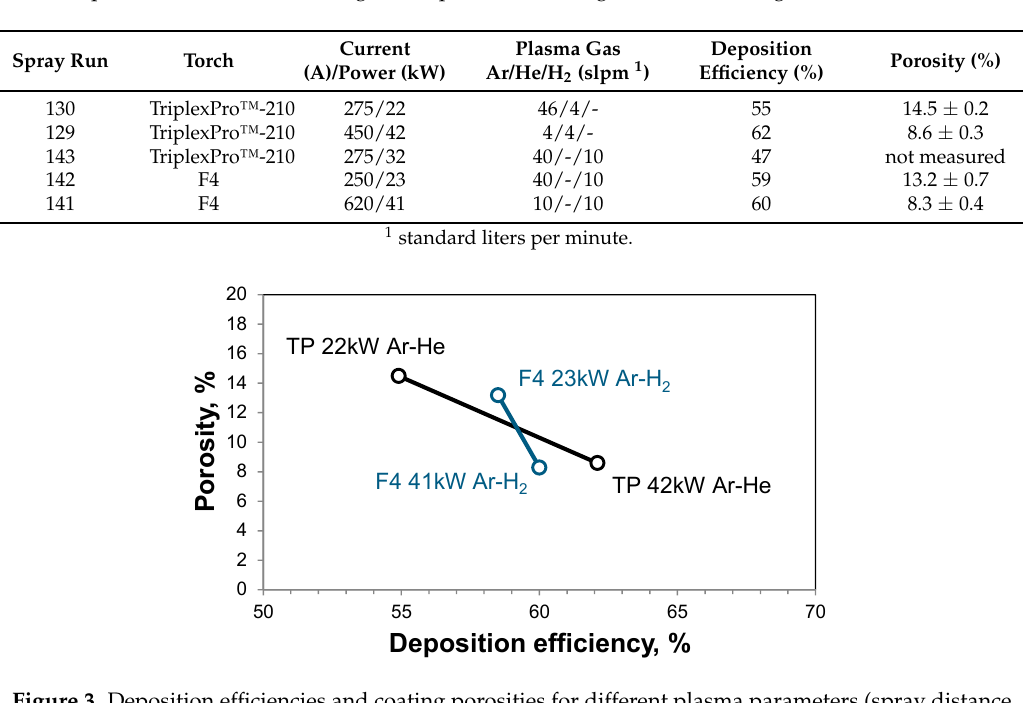
Figure 2. Back ‐ scattered electron image and energy ‐ dispersive X ‐ ray spectrometry (EDS) elemental mappings of a coating sprayed with TriplexPro™ ‐ 210 at high power (42 kW) and with Ar–He plasma gas mixture porosities (powder 321 M, spray distance 90 mm). Table 3. Effect of plasma parameters on deposition efficiencies and coating porosities (spray distance 90 mm, powder 321 M, feed rate 8 g/min.); porosities averaged from two images.